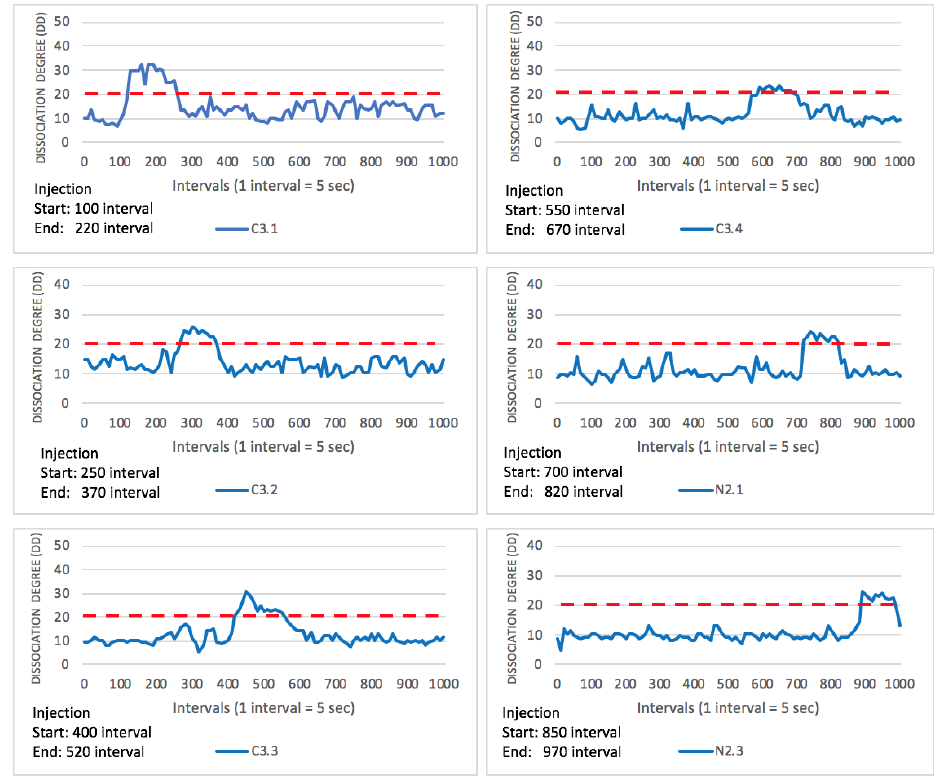
Figure 6. Memory leak detection using HHMM for